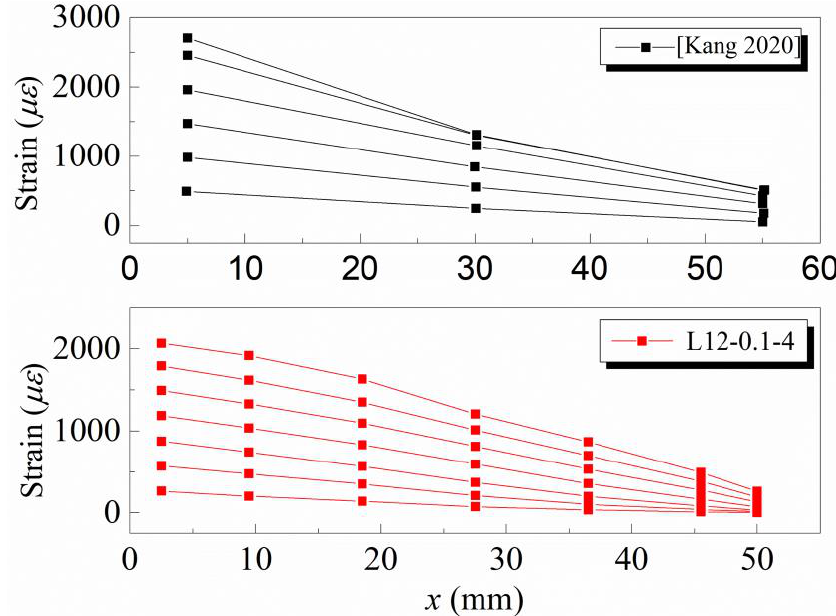
Figure 8. Strain variations of x i – average strain at different loading levels [22].